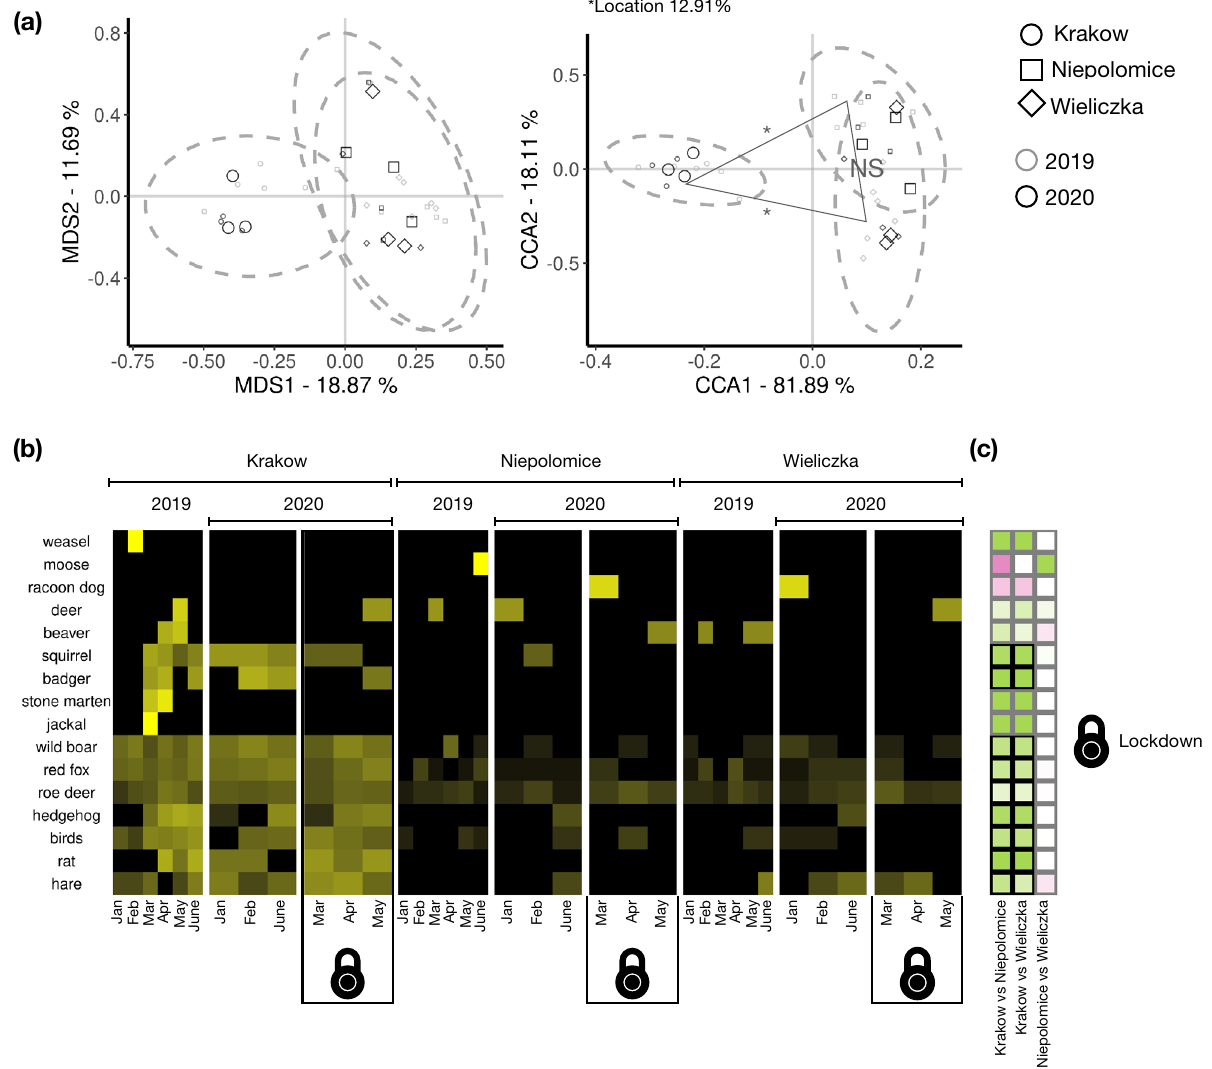
Figure 1. Effect of urbanisation and lockdown on AVC ( a ) Unconstrained ordination shows Multidimensional scaling analysis (MDS) plot (left) displaying the variance explained in component 1 and 2. Constrained ordination (right) showed the variance by location as the constraining factor and year as random factor. The shapes represent the three study locations. The black shapes represent 2020 and grey shapes represent 2019. NS = Not significant; * = p ≤ 0.05 represents significance between locations determined by pairwise PERMANOVA. The ellipses represent 95% of the confidence interval; ( b ) The heatmap displaying the percentage of AVC (intensity of colour black to yellow) for the animals reported (y-axis) over a period of month (x-axis) across year for specific location. The lockdown month is facetted out in the year 2020 for the corresponding locations. ( c ) The pairwise comparative statistics performed on location as fixed